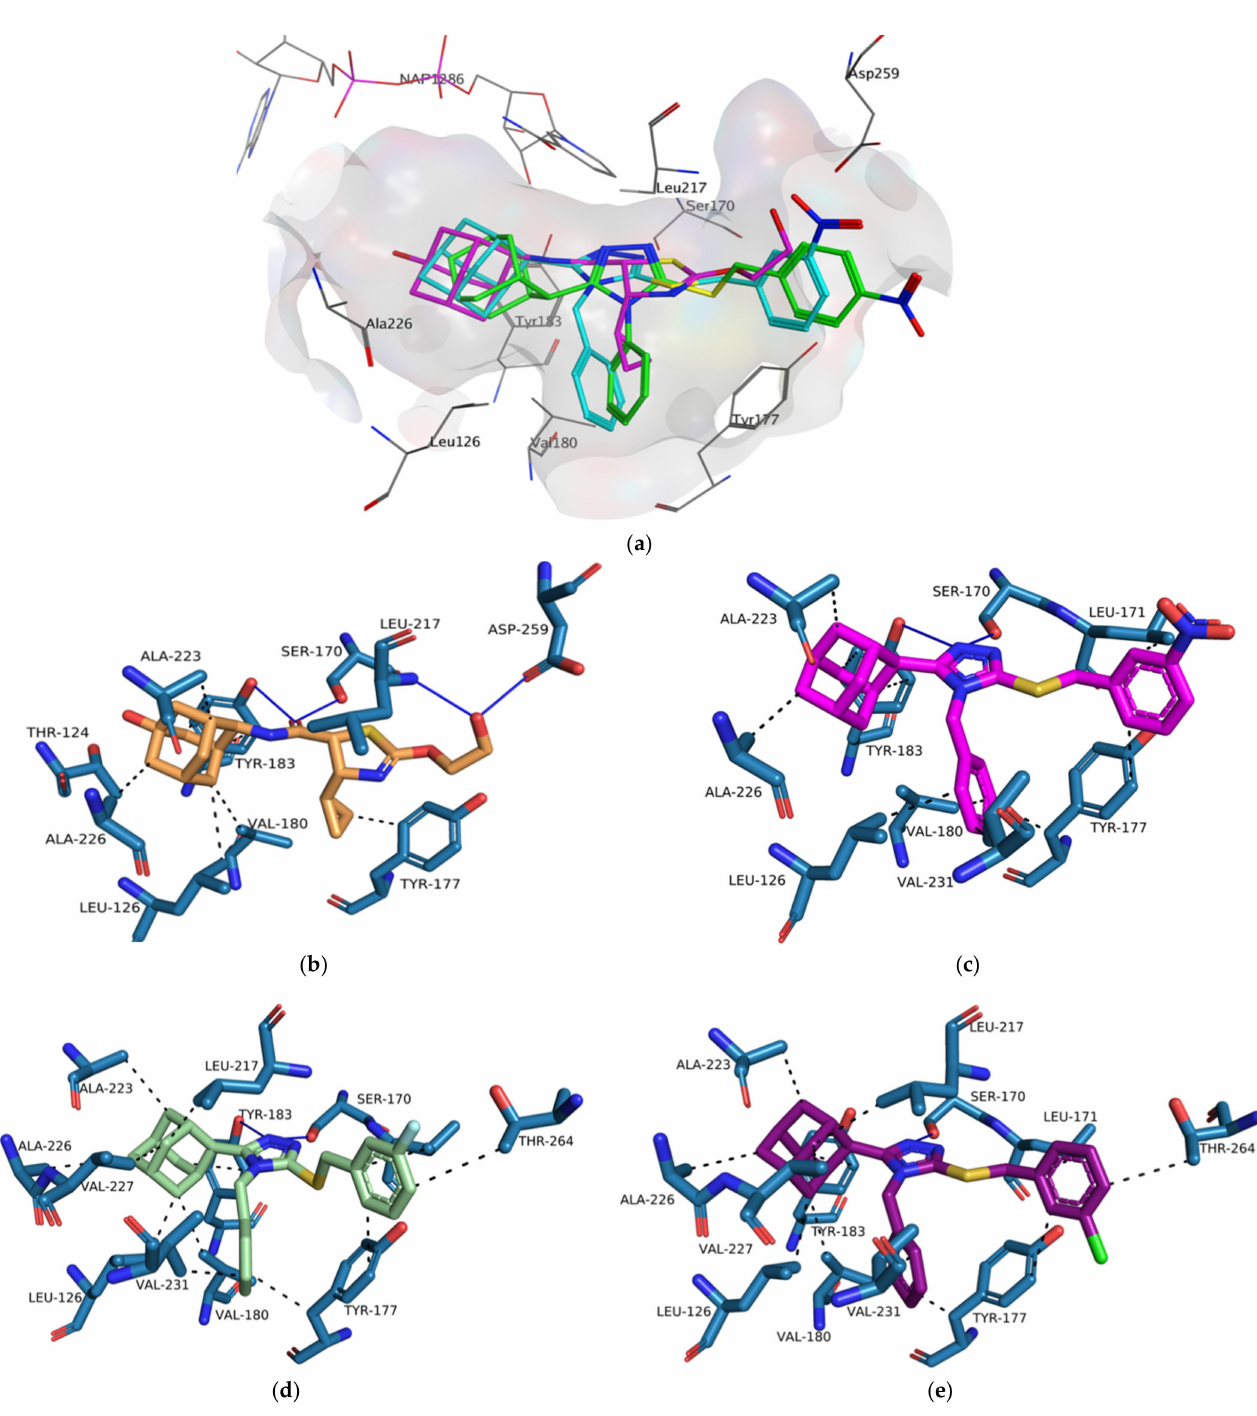
Figure 13. ( a ) The binding orientations of 4YQ (magenta), compound 1 (blue) and compound D4 (blue) within the 11 β -HSD1 active site are shown using (MOE) 2020 software suite [53]. Compound D4 has shifted deeper into the and the triazole moiety has rotated to a more planar orientation in reference to Ser 170 and Tyr 183 when compared to compound 1 . The binding orientations and interactions of 4YQ ( b ), D4 ( c ), D5 ( d ) and D6 ( e ) within the 11 β -HSD1 active site are shown were analyzed on PLIP [48] and visualized using Pymol molecular graphics system [54]. The hydrogen bond and hydrophobic interactions are indicated by the solid blue and black dashed lines